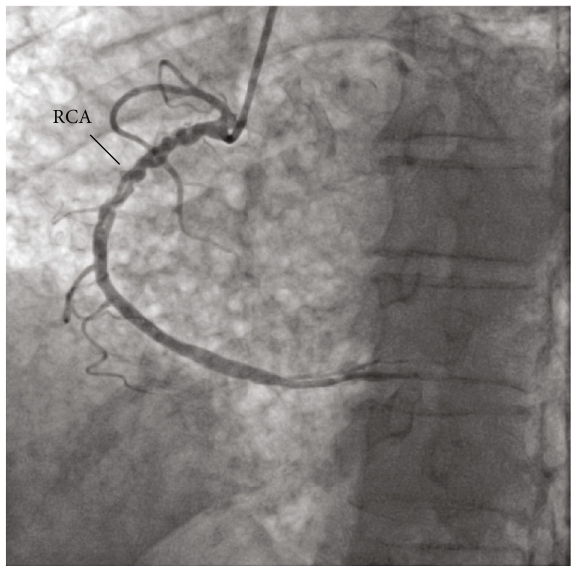
Figure 1: Left anterior oblique (LAO) view of right coronary artery (RCA), demonstrating braid-like lesion.